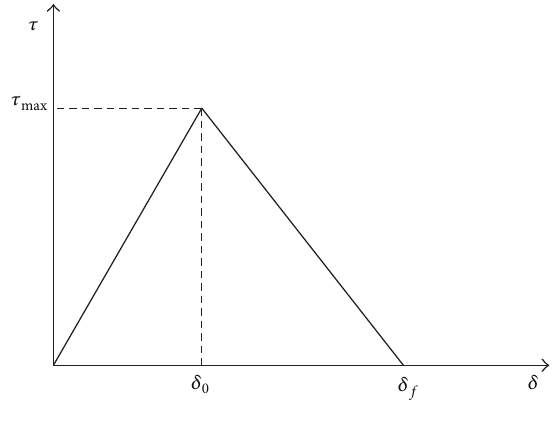
Figure 5: Bilinear bond-slip